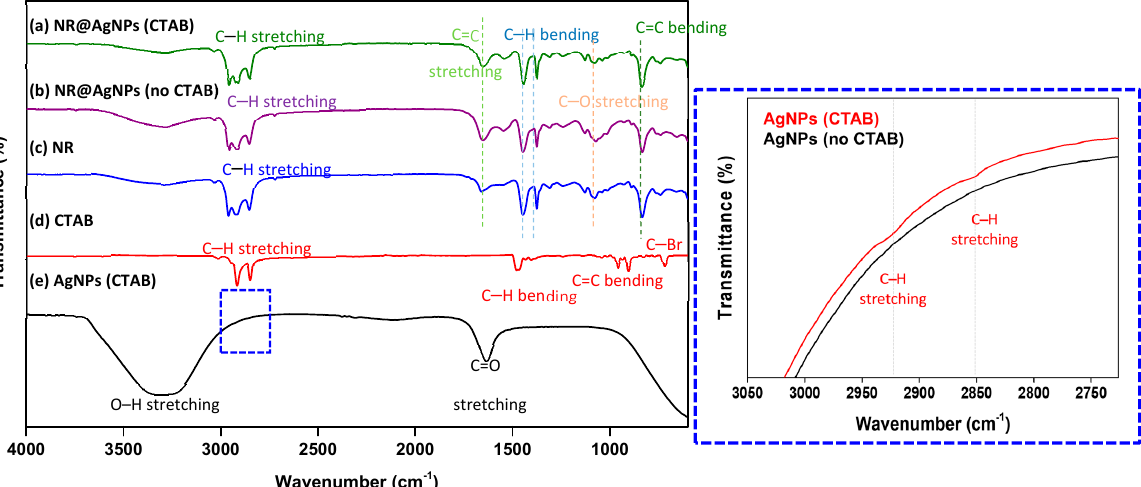
Figure 4. FTIR spectra of NR@AgNPs (CTAB) compared to NR@AgNPs (no CTAB), NR, pure CTAB and AgNPs and the inset presenting the presence of CTAB in the AgNPs (CTAB) but not in AgNPs (no CTAB).